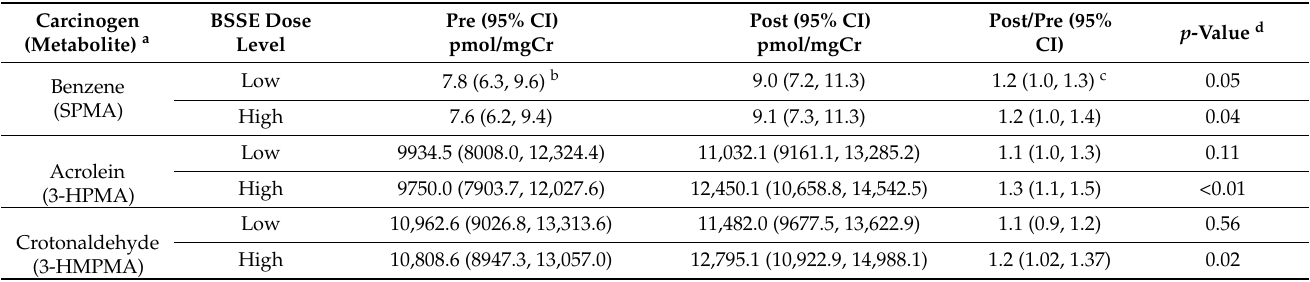
Table 2. Urinary excretion of carcinogen